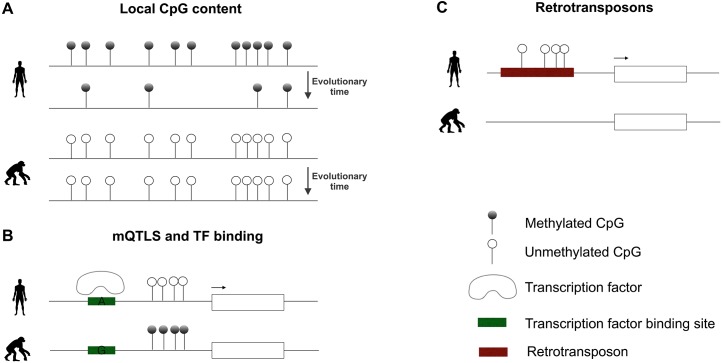
The interplay between the genome and the methylome.A) Methylated cytosines tend to deaminate over evolutionary time and, thus, the methylation state of cytosines in different species influences the evolution of the underlying genome sequence. B) Species-specific nucleotide changes that disrupt transcription factor (TF) binding sites can alter the methylation state of nearby CpG dinucleotides and, as a consequence, establish species-specific differentially methylated regions (DMRs). C) The insertion of transposable elements in a particular lineage, along with the accumulation of nucleotide changes, can lead to the emergence of novel CpG dinucleotides, creating species-specific regulatory regions.